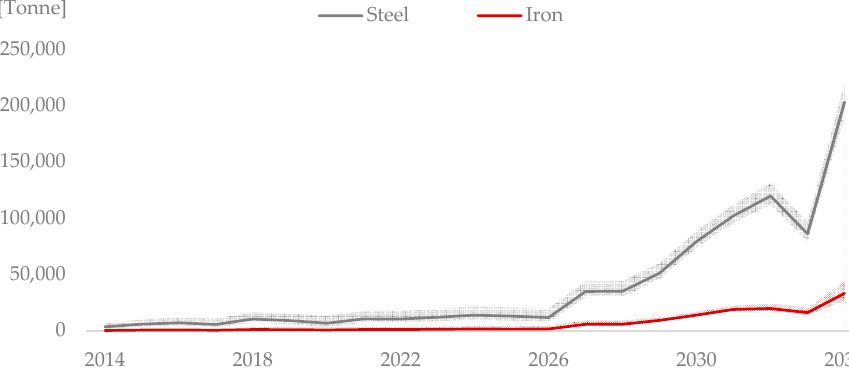
Figure 6. Estimated amounts of steel and iron waste generated from the Swedish wind power industry between 2014 and 2034. The solid line is the result of using the mean material specification and the area shows the range between applying the minimum and maximum values found.